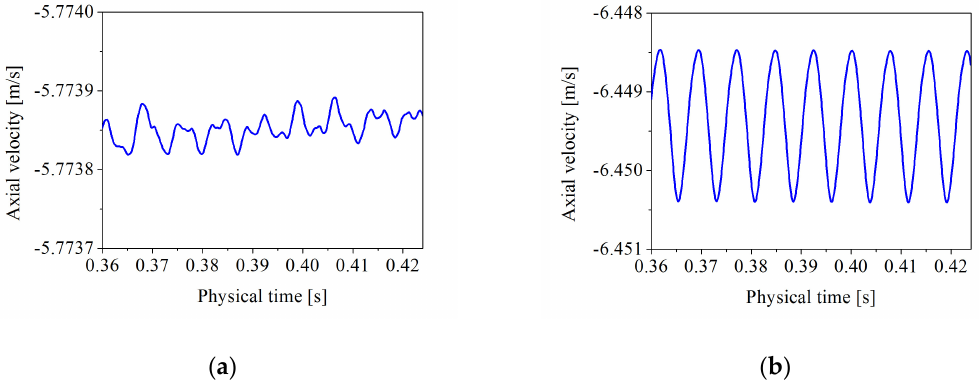
R ) and ( b ) P2 (0, 0.5 × R , − 1.0 × R ). Figure 11. Axial velocity as a function of physical time at di ff erent locations: ( a ) P1 (0, 0.9 R , − 0.5 R ) and Figure 11. Axial velocity as a function of physical time at different locations: ( a ) P1 (0, 0.9 × R , − 0.5 ×